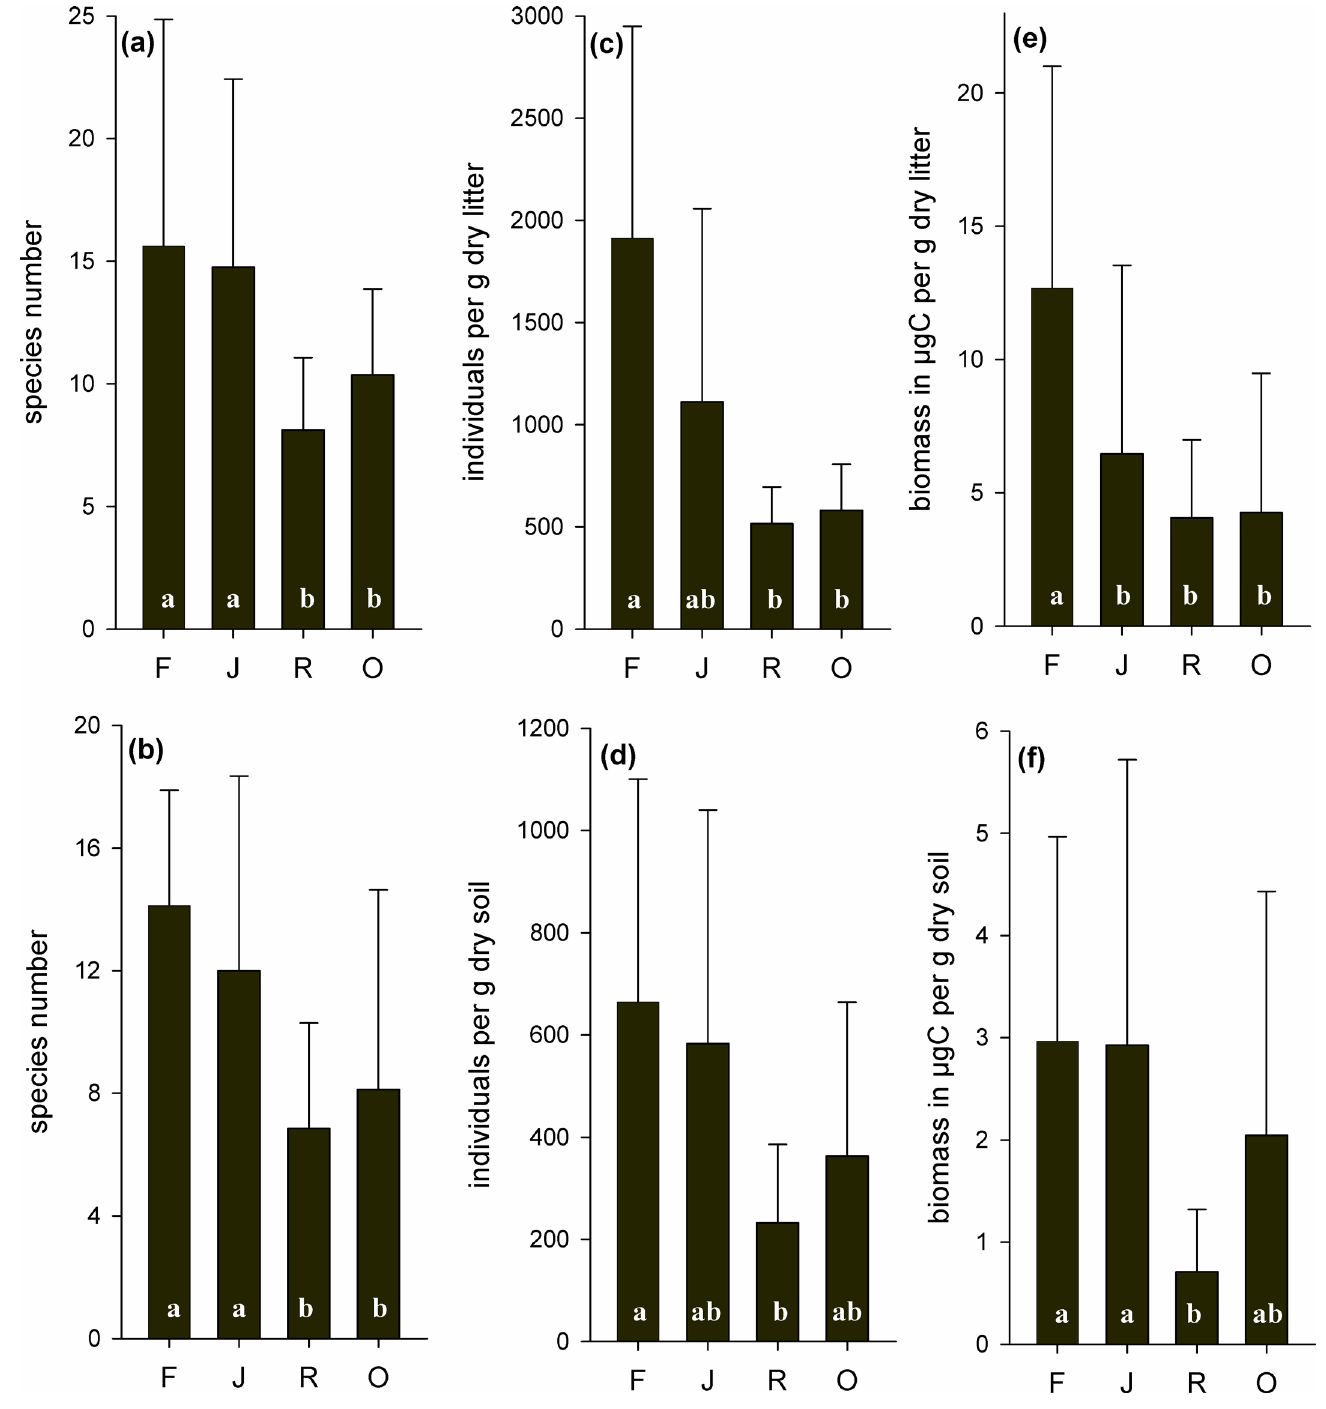
Fig 1. Species number (a, b), density (c, d) and biomass (e, f) of living testate amoebae in litter (upper panel) and soil (lower panel) of four land-use systems: rainforest (F), jungle rubber (J), rubber (R) and oil palm (O); means with SD (n = 8). Bars sharing the same letter do not differ significantly (Tukey ’ s HSD test, p <